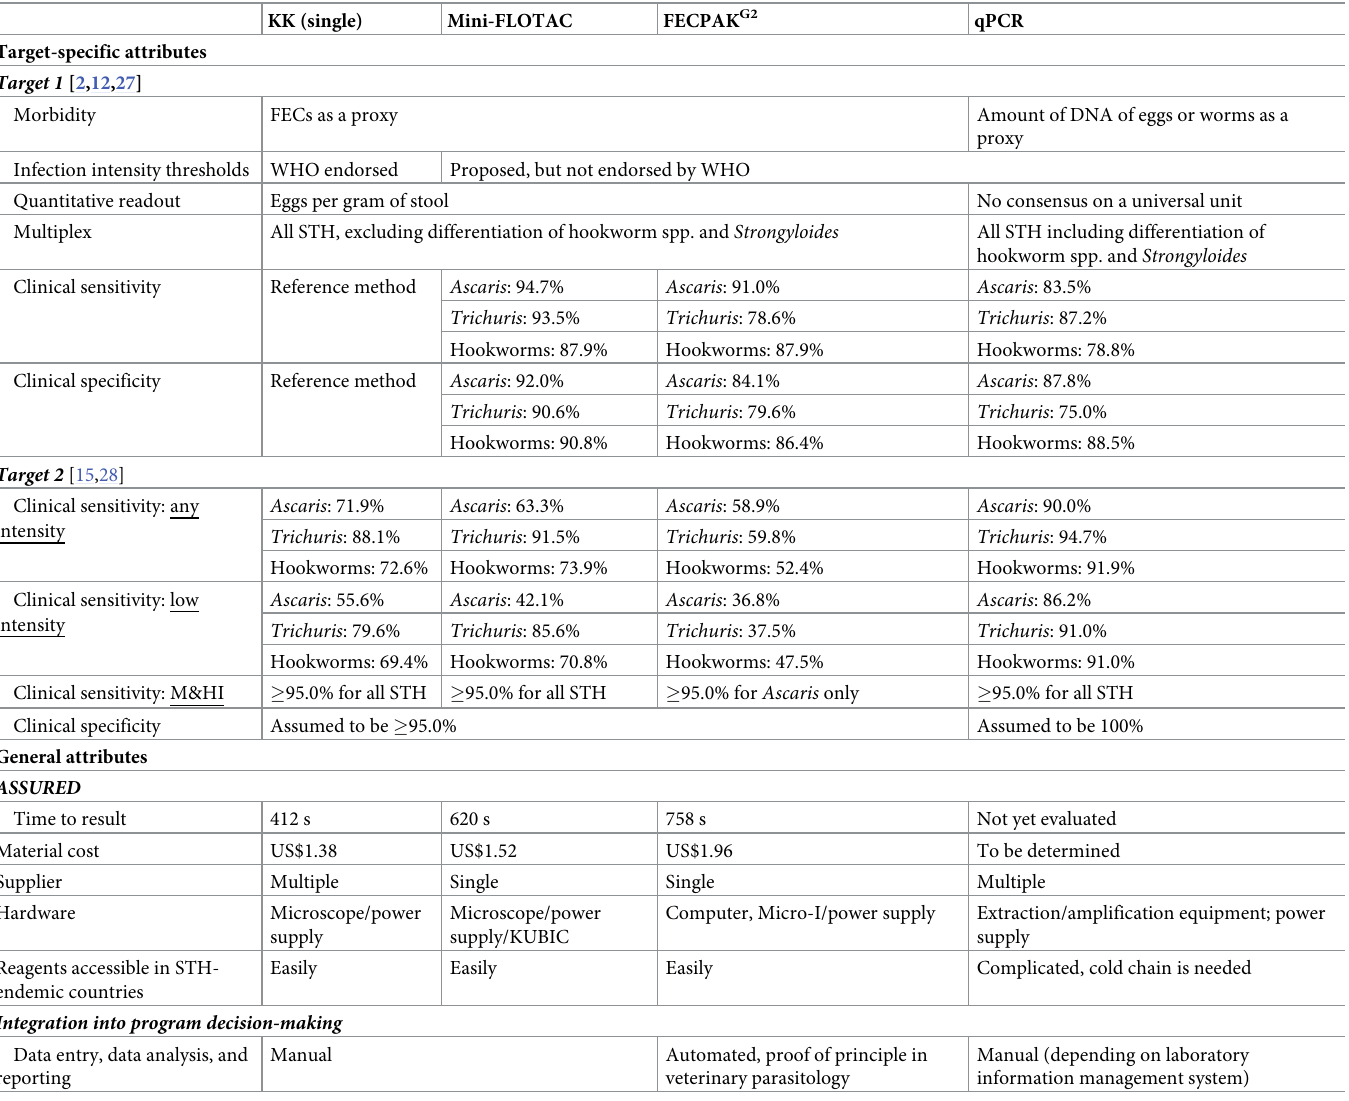
Table 2. Matching current stool-based technologies with the diagnostic attributes to measure or make progress toward 2030